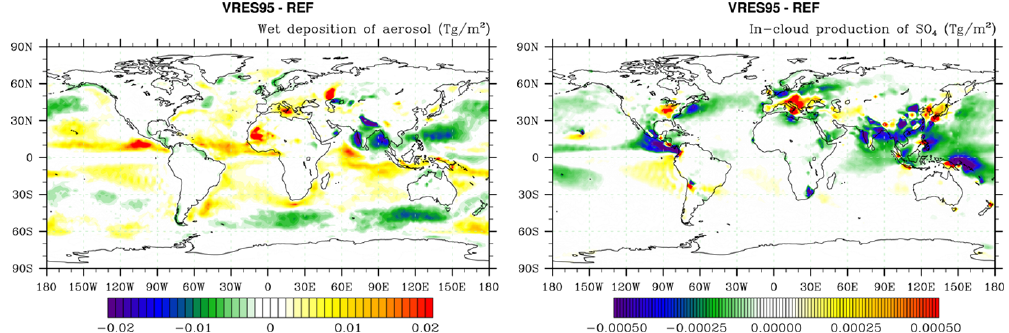
Figure 14. The change in wet deposition of aerosol mass and the change in production of SO 4 by wet chemistry between the VRES95 and the REF experiment.